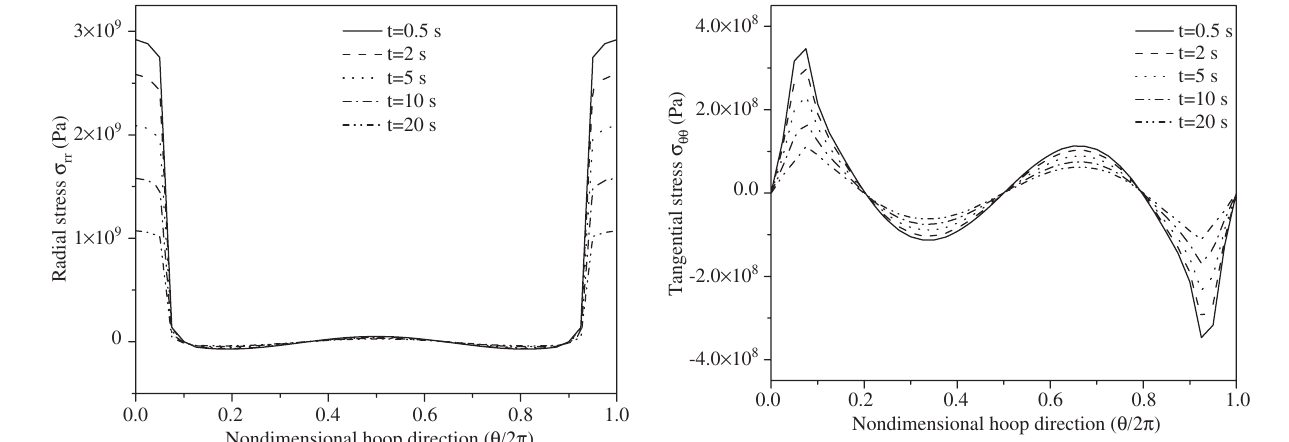
Figure 20 Distributions of radial stress along the hoop direction of the FGM hollow cylinder at different times.